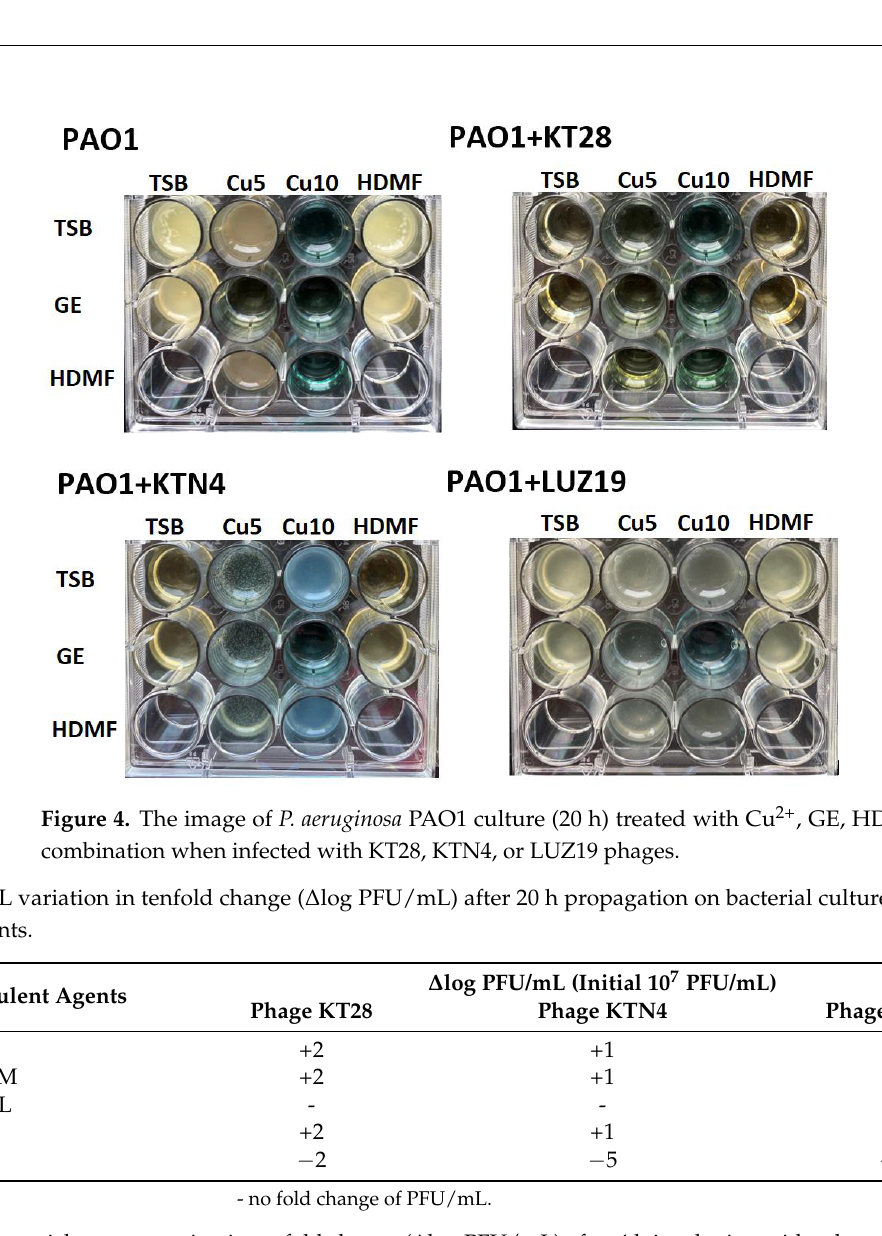
Table 2. Phage infective particles enumeration in tenfold change ( ∆ log PFU/mL) after 4 h incubation with selected